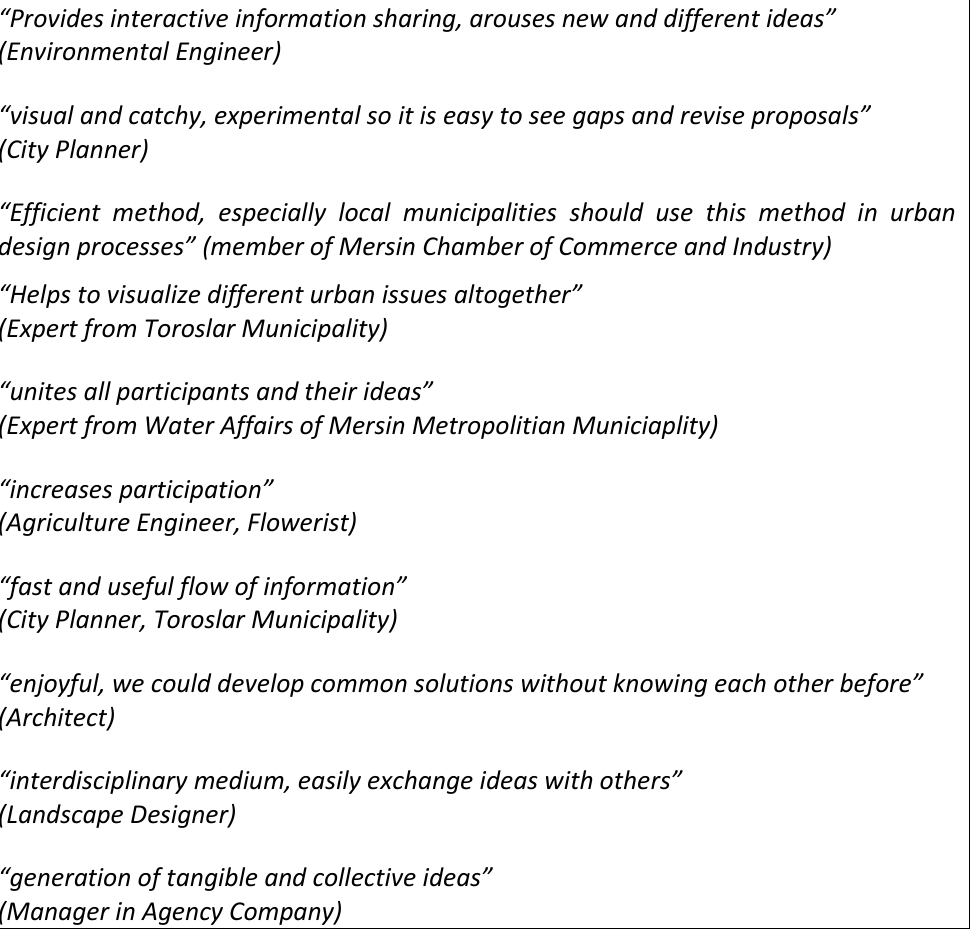
Table 2 Feedbacks from participants in Game Session #